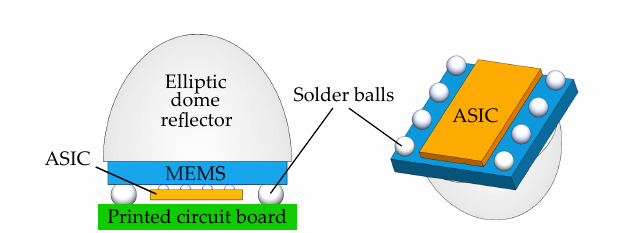
Figure 6. Integrated optical gas sensor concept. Planar integration of emitters and detectors within the same micro-electro-mechanical systems (MEMS) chip, facing an optimized multi-reflection elliptic mirror (gas cell). The sensor signal can be enhanced with an on-chip amplifier and have the first analogue processing level done on-chip with more complex signal processing done externally through the use of an application-specific integrated circuit (ASIC). The MEMS and ASIC chips are attached via face-to-face flip-chip